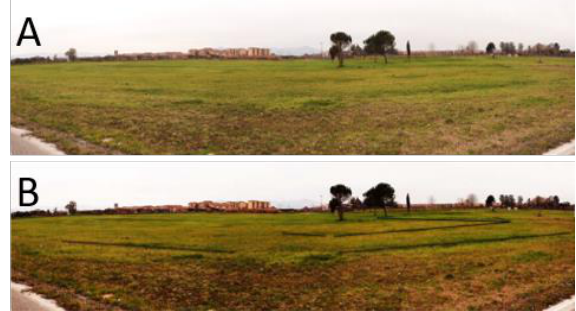
Figure 4. Perimeter wall traces captured in a low-tilt photo (A), enhanced with a black line in the picture (B)